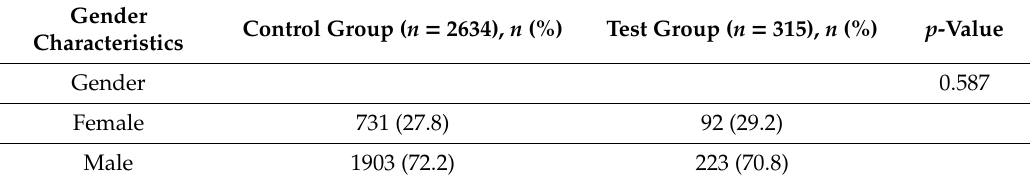
Table 4. Comparison of demographic characteristics gender (chi-square test).